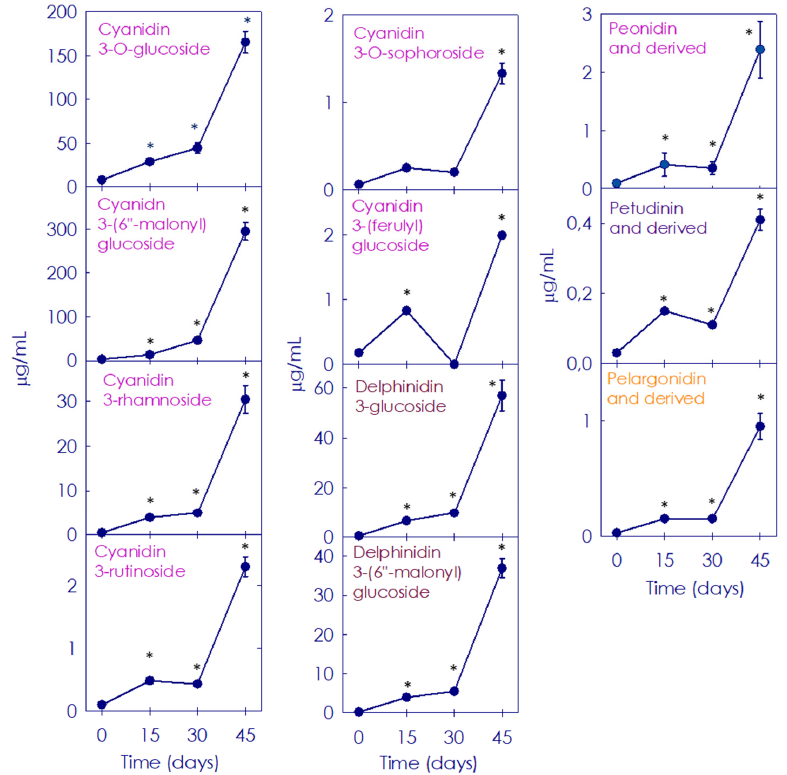
Figure 6. Composition of anthocyanins in the pulp of Moro blood orange during storage for 0, 15, 30 and 45 days. Data are expressed as the mean ± SD of each sample as compared to the control sample (Moro fruit at harvest time). Asterisk indicates statistically significant different values ( p ≤ 0.01) for each given time.